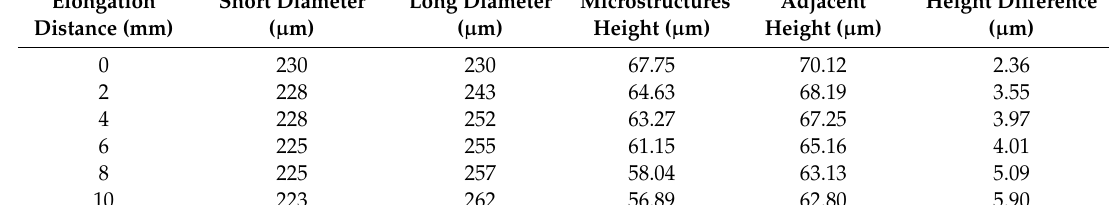
Table 4. Contour features after uniaxial tensile curved imprinting forming.